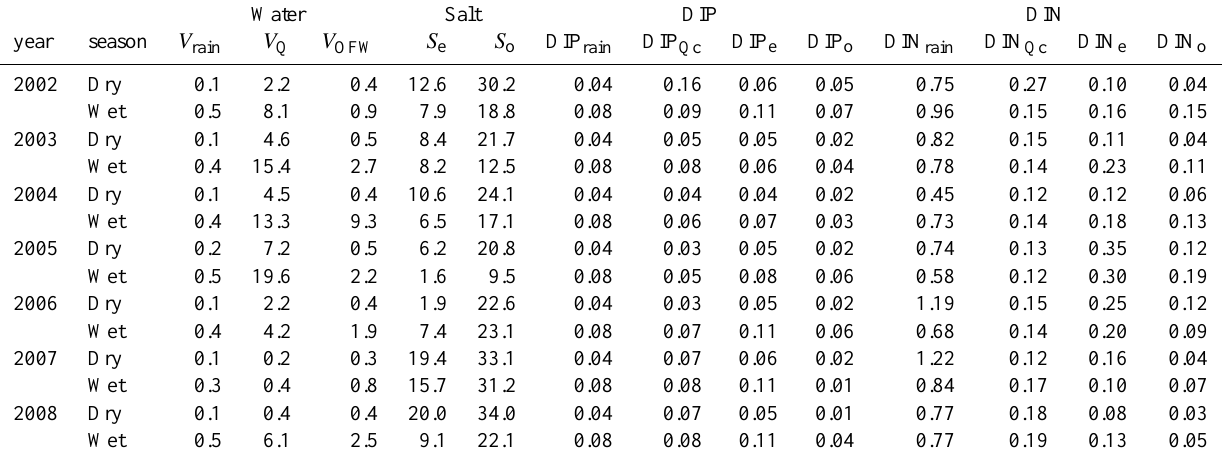
Table 2. Inputs for seasonal DIN and DIP budgets for the CRE. Values are seasonal averages from 2002 to 2008 for water, salt, DIN, and DIP budgets. The wet season consisted of months 6–11 (June–November) within each year. The dry season consisted of month 12 (December) from the preceding year followed by the first 5 months (January–May) of the next year. Abbreviations and units shown for average daily input of rain ( V rain ; 10 6 m 3 d − 1 ) , upstream flow or discharge ( V Q ; 10 6 m 3 d − 1 ) , and other freshwater sources ( V OFW ; 10 6 m 3 d − 1 ) ; salinity in the estuary ( S e ) and downstream or ocean boundary ( S o ); and concentrations of DIN and DIP in rainfall (DIN rain and DIP rain ), discharge (DIN Qc and DIP Qc ), the estuary (DIN e and DIP e ) , and the ocean boundary (DIN o and DIP o ). All concentrations are in gm − 3 . DIN and DIP in other freshwater sources (DIN OFW and DIP OFW ) were assumed to be equal to DIN Qc and DIP Qc . See text for specifics and sources